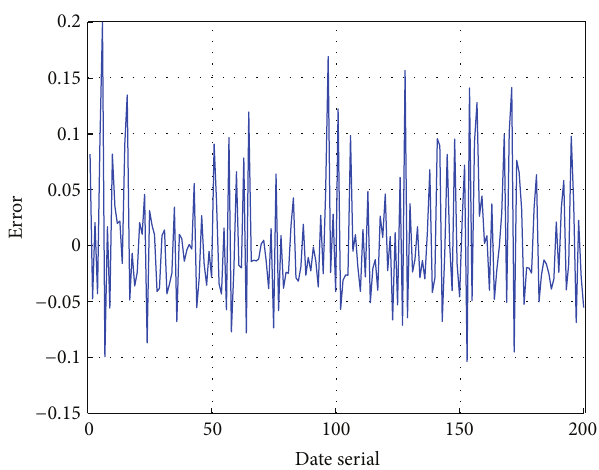
Figure 6: The estimated output and observations.